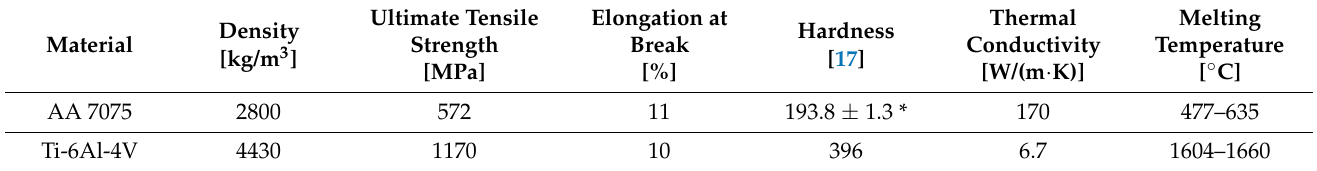
Table 1. Physical and mechanical properties of the base materials used to produce dissimilar